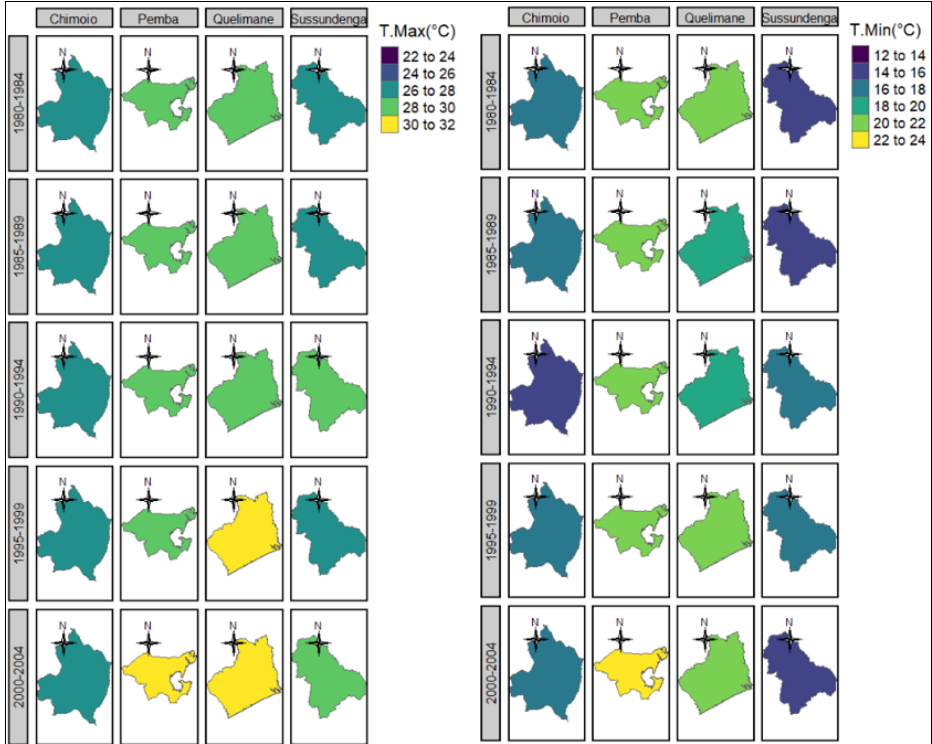
Figure 7. Temperature changes at 5-year intervals in the districts where meteorological stations are located in Mozambique.